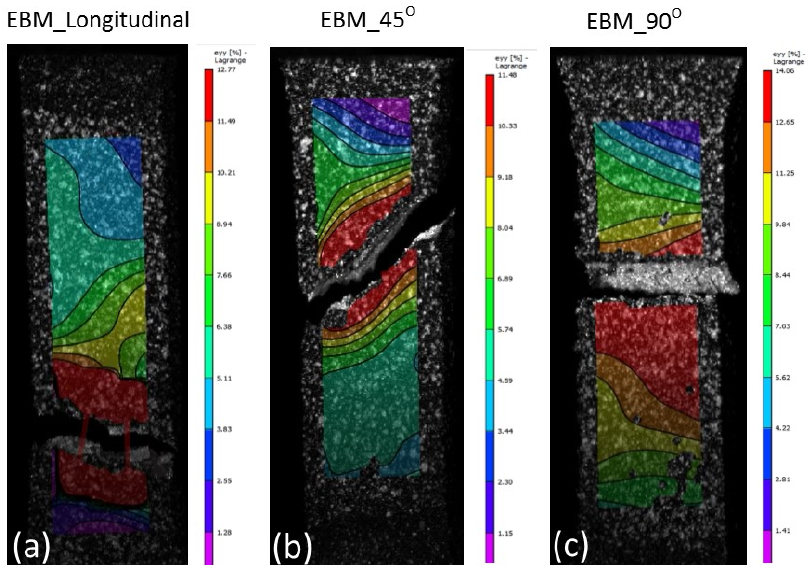
Figure 9. DIC images showing all samples at fracture states of EBM material. Note the maximum elongations at fracture locations were about ( a ) 13%, ( b ) 12% and ( c ) 14% on the 0°, 45° and 90°, respectively.